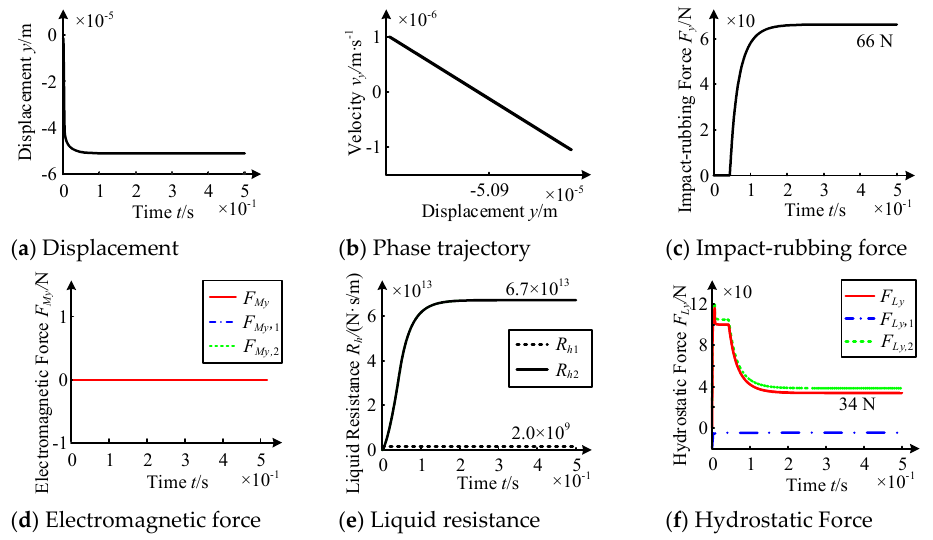
Figure 19. Operating law under upper and lower unit failure. According to Figure 19, the drop stage mainly occurs within 0.04 s. In this stage, the rotor displacement decreases rapidly, which indicates the rotor has a high speed, resulting in a rapid rise in the hydrostatic supporting force F Ly . The fluid resistance R h 2 of the upper supporting unit shows little change, but the fluid resistance R h 2 of the lower supporting unit increases rapidly due to the dynamic extrusion effect. The resultant electromagnetic force F My is